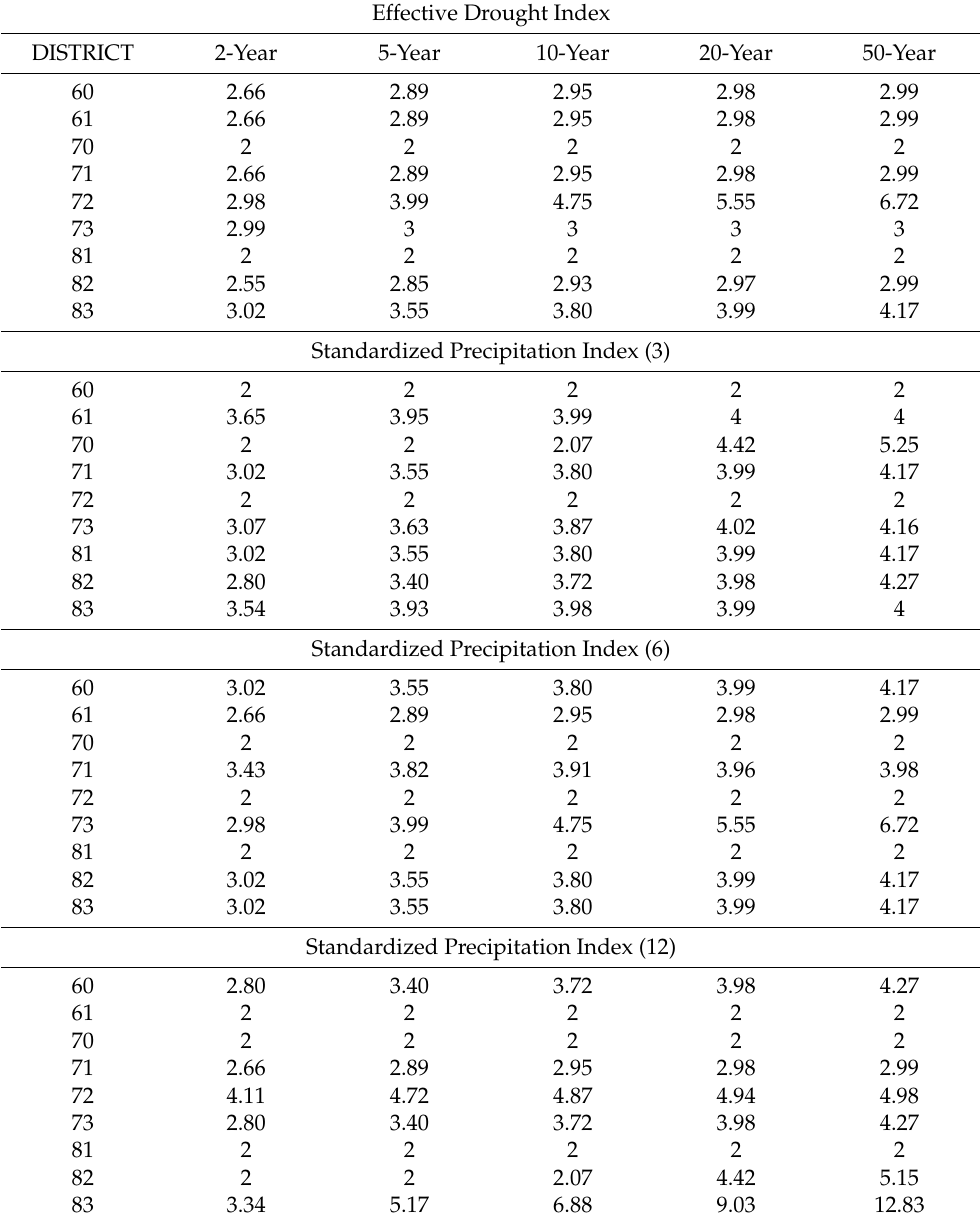
Table 3. Wet durations return levels for 2-, 5-, 10-, 20-, and 50-year